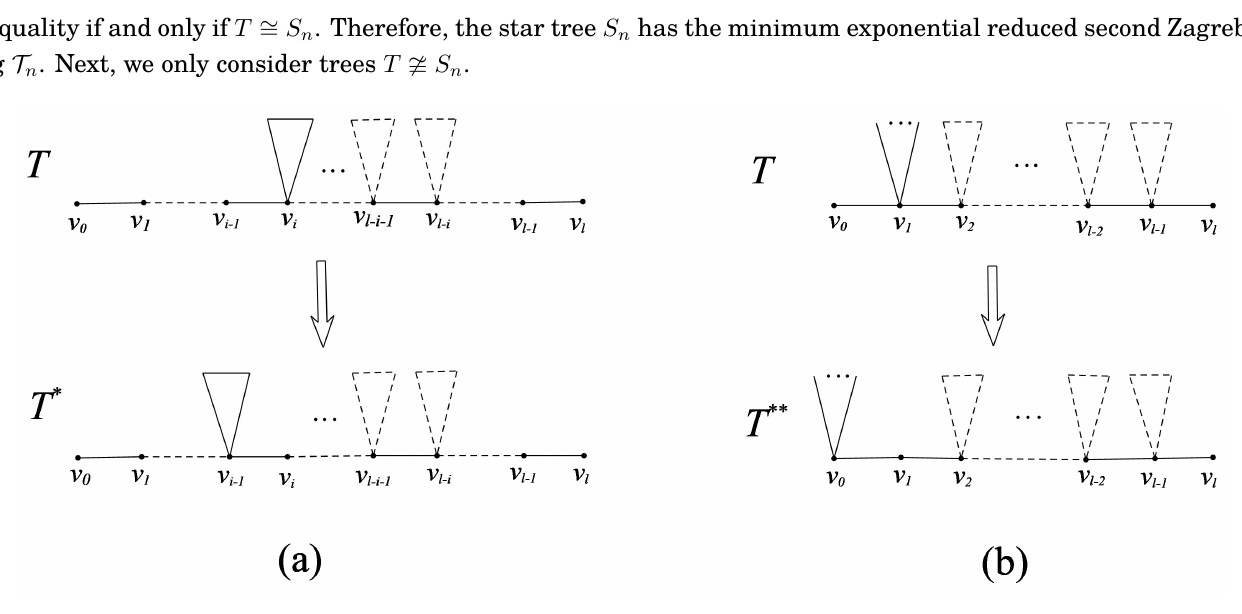
Figure 1: Transformations used in the proof of Theorem